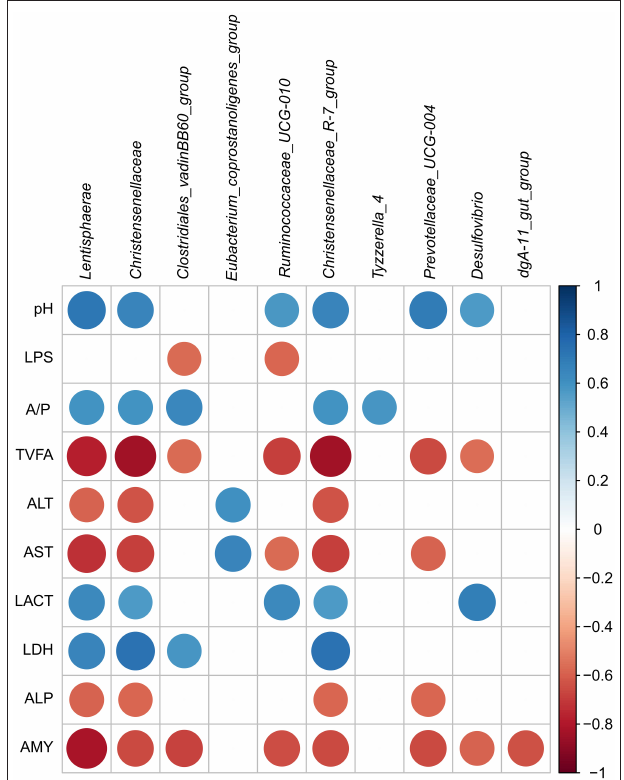
FIGURE 6 | Correlation analysis among the intestinal pH, SCFA, and metabolites and associated microbiota composition of hindgut. Only results obtained for which the abundance was significantly associated with intestinal metabolites were shown. Cells were colored based on Pearson’s correlation coefficient between the metabolites and associated microbiota composition in the hindgut (red and blue indicated negative and positive correlations,